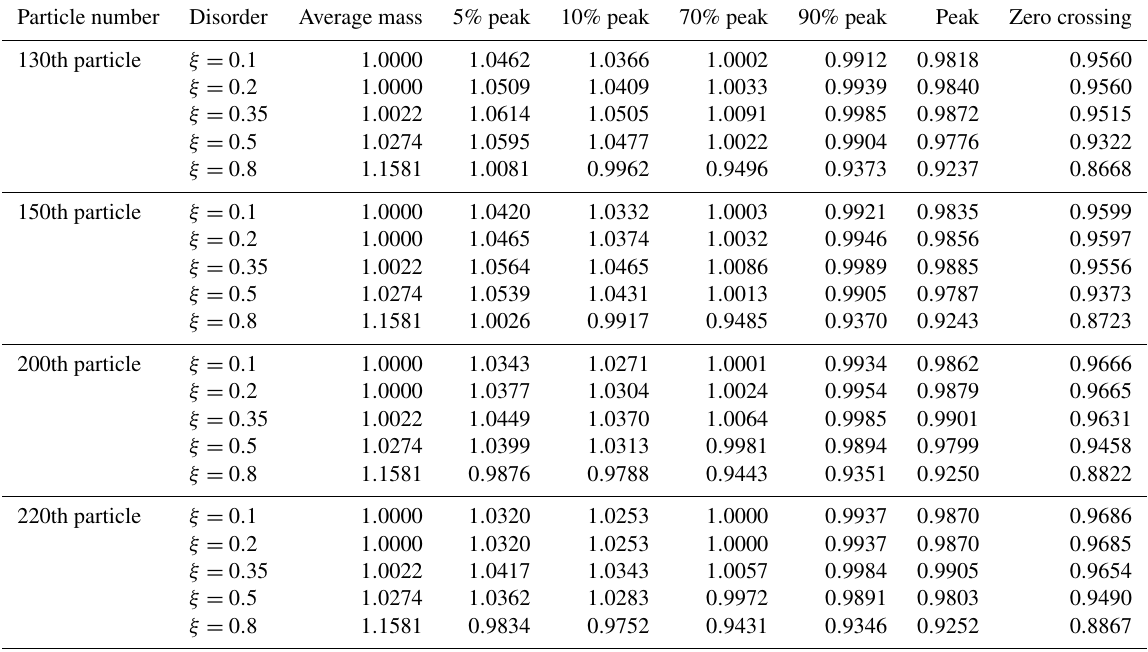
Table 5. Unscaled coherent wave velocity picking ( with normal distribution (256 elements long, 500 ensembles).